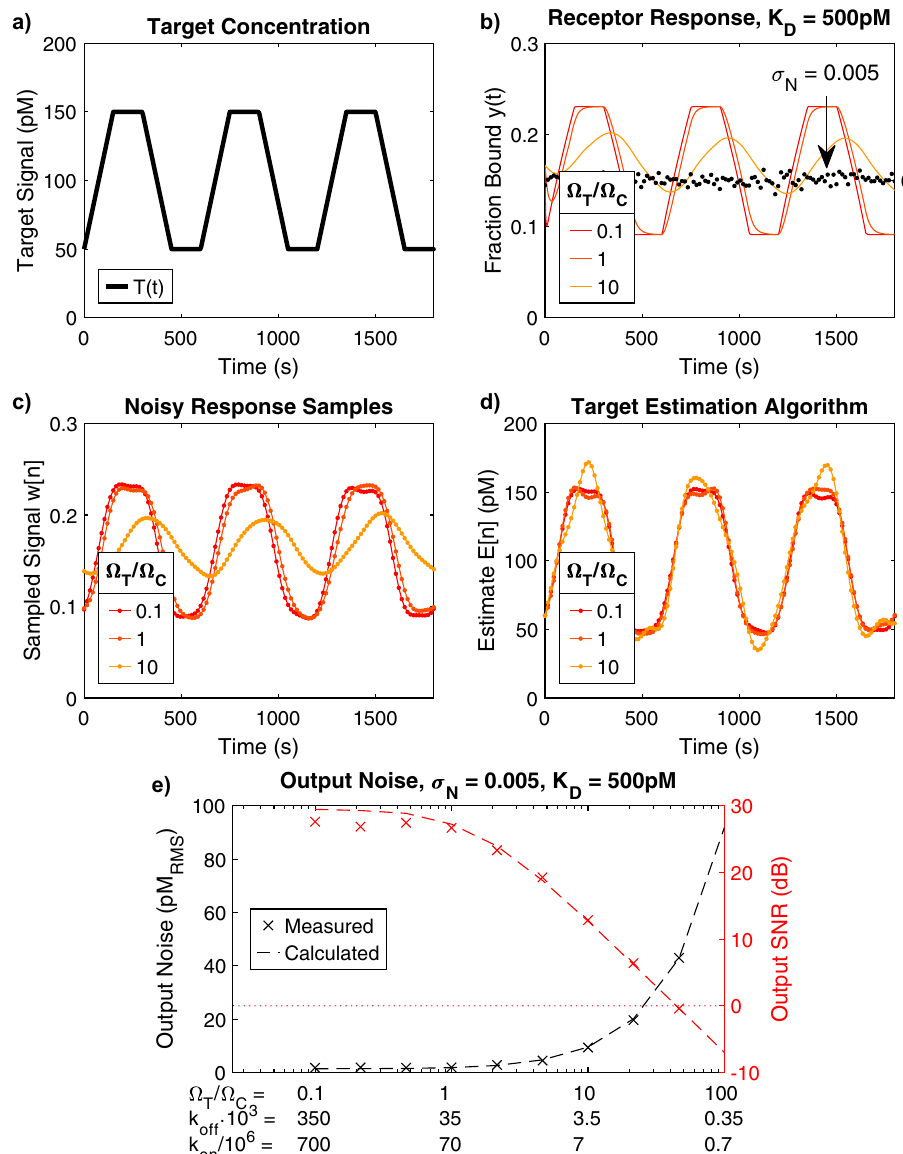
Fig. 7 | End-to-end SNR simulation of insulin sensor. a A trapezoidal test con- centration signal with T 0 =100 pM, T 1 =50 pM, and a period of 10min (1/600Hz). b We simulated the response of three receptors with constant K D = 500 pM but decreasing kinetics, where Ω T / Ω C = 0.1, 1, or 10. Also shown for comparison is the noise N [ n ]introduced bythe detectorsystem(blackdots). N [ n ] iszero-meanwhite noise with a standard deviation of 0.005 fraction bound. c The receptor response was sampled with f S = 1/15Hz, combined with N [ n ], and then fi ltered to remove all